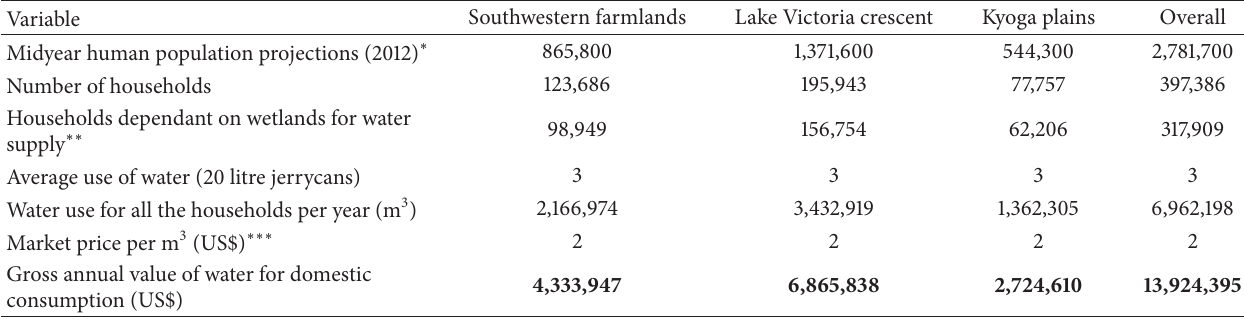
Table 9: The gross annual monetary value of wetlands for domestic water supply in three agro-ecological zones in